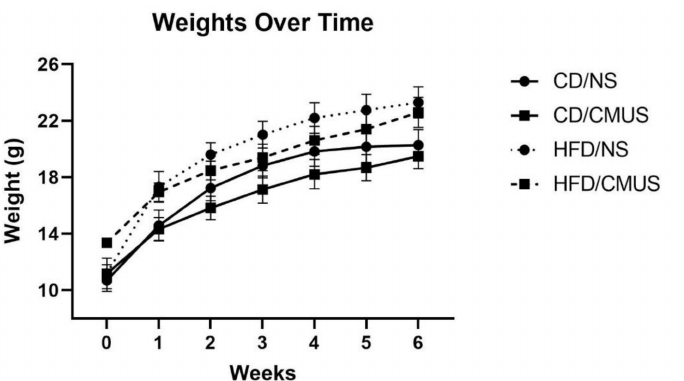
Figure 1. Weights over time. Weights increased significantly over the course of the experiment ( p < 0.001). High-fat diet (HFD) mice weighed significantly more than those on control diet (CD)